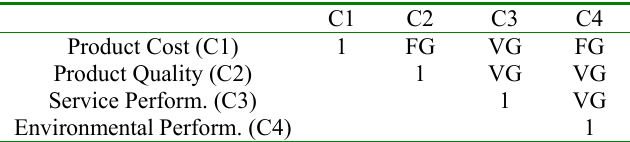
Table 2. Linguistic evaluation matrix of DM1 for main criteria